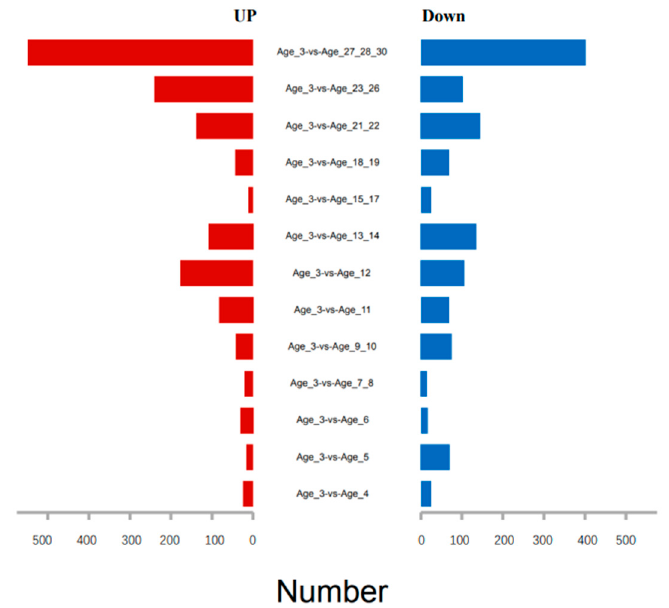
Figure 1. The number of differentially expressed genes of giant pandas in different age groups compared to three-year-old groups.